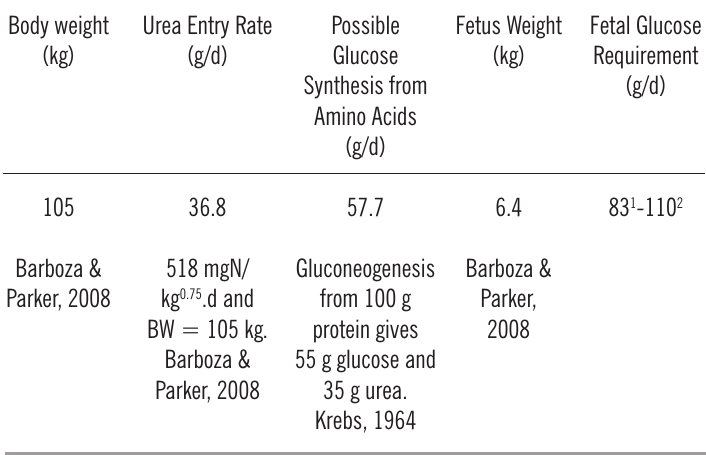
Table 1. Estimation of glucose synthesis by a caribou at term gesta- tion based on isotope estimates of urea production. At 58 g/d this synthesis would require the metabolism of 105 g protein. Compari- son is made with the likely demand for glucose by the fetus. An es- timate made from the irreversible loss (IL) of glucose measured in near-term reindeer and caribou minus the glucose IL measured in non-pregnant animals fed at maintenance. A second estimate of fetal demand is calculated from the glucose uptake of the conceptus at term in